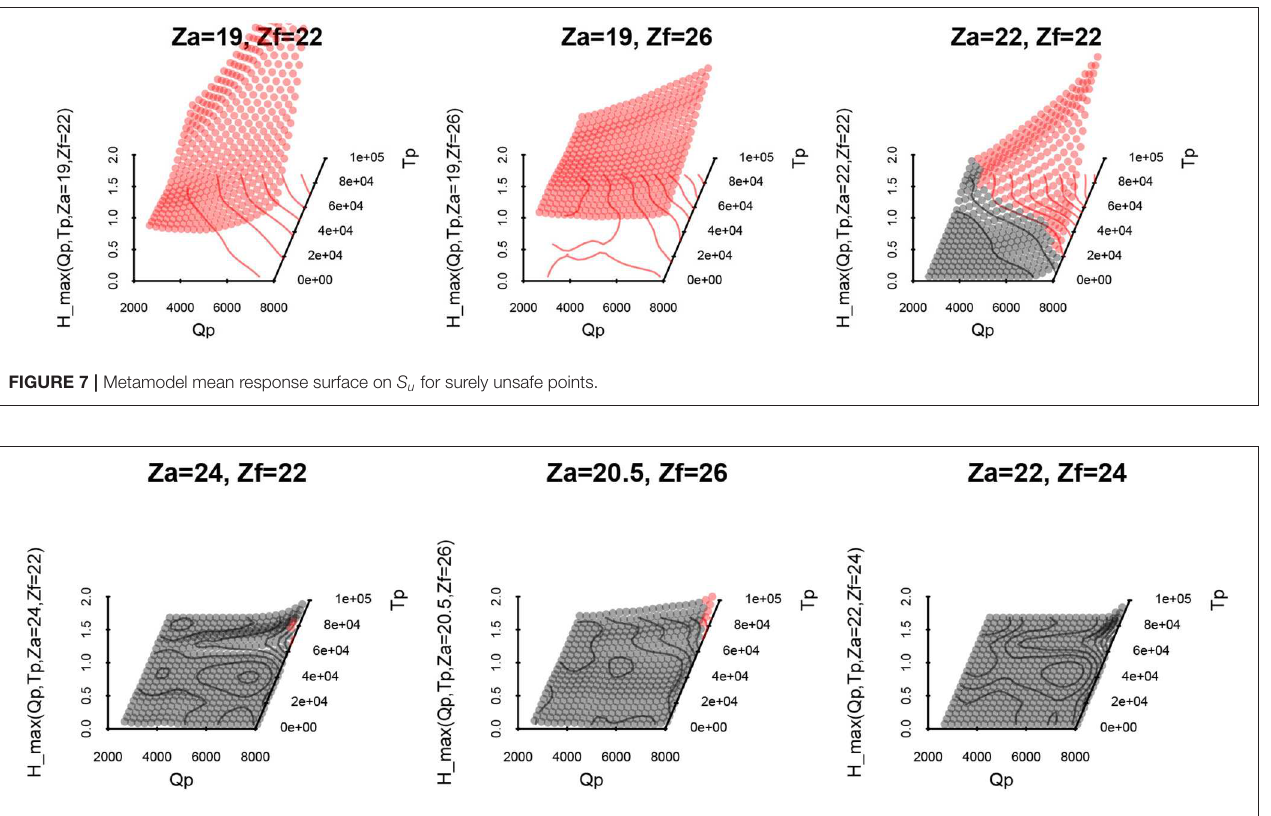
FIGURE 8 | Metamodel mean response surface on S u for safety limit points.